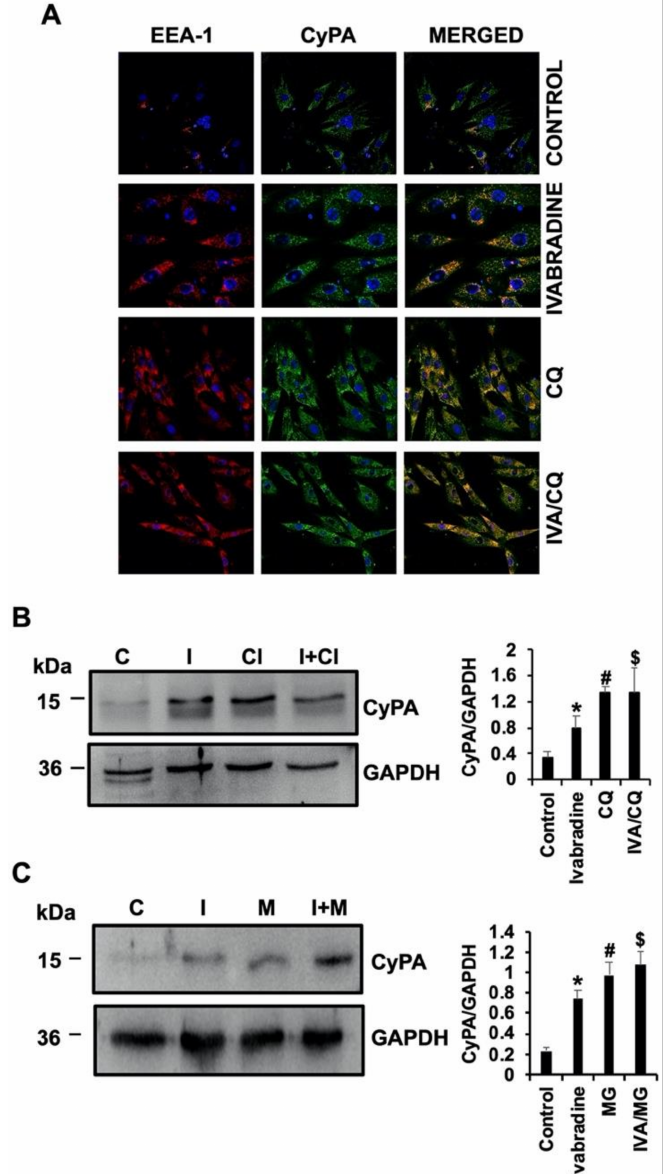
Figure 6. Ivabradine has no effect on CyPA degradation. ( A ) Confocal microscopic detection of EEA-1 (red) and CyPA (green) in H9c2 cells incubated with Ivabradine, chloroquine, and a combination of both. Merged panels show co-localization in yellow ( n = 3). ( B ) Immunoblot detection of CyPA and GAPDH as a loading control in protein lysates from cells incubated with Ivabradine, chloroquine, and a combination of both ( n = 3, mean ± SD, * p < 0.03 control vs. Ivabradine. # p < 0.01 control vs. chloroquine (CQ), $ p < 0.006 control vs. CQ/iva). ( C ) Immunoblot detection of CyPA and GAPDH in protein lysates from cells incubated with Ivabradine, MG-132, and a combination of both ( n = 3. Mean ± SD; * p < 0.003 control vs. Ivabradine. # p < 0.005 control vs. MG. $ p < 0.005 control vs.